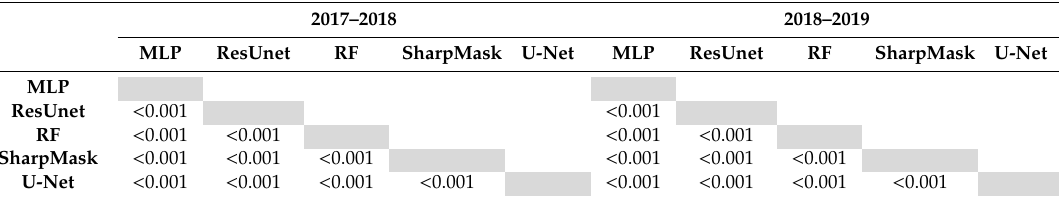
Table 4. McNemar’s test p-values between model classifications. Values bellow p = 0.05 indicate the di ff erences between classifications are statistically